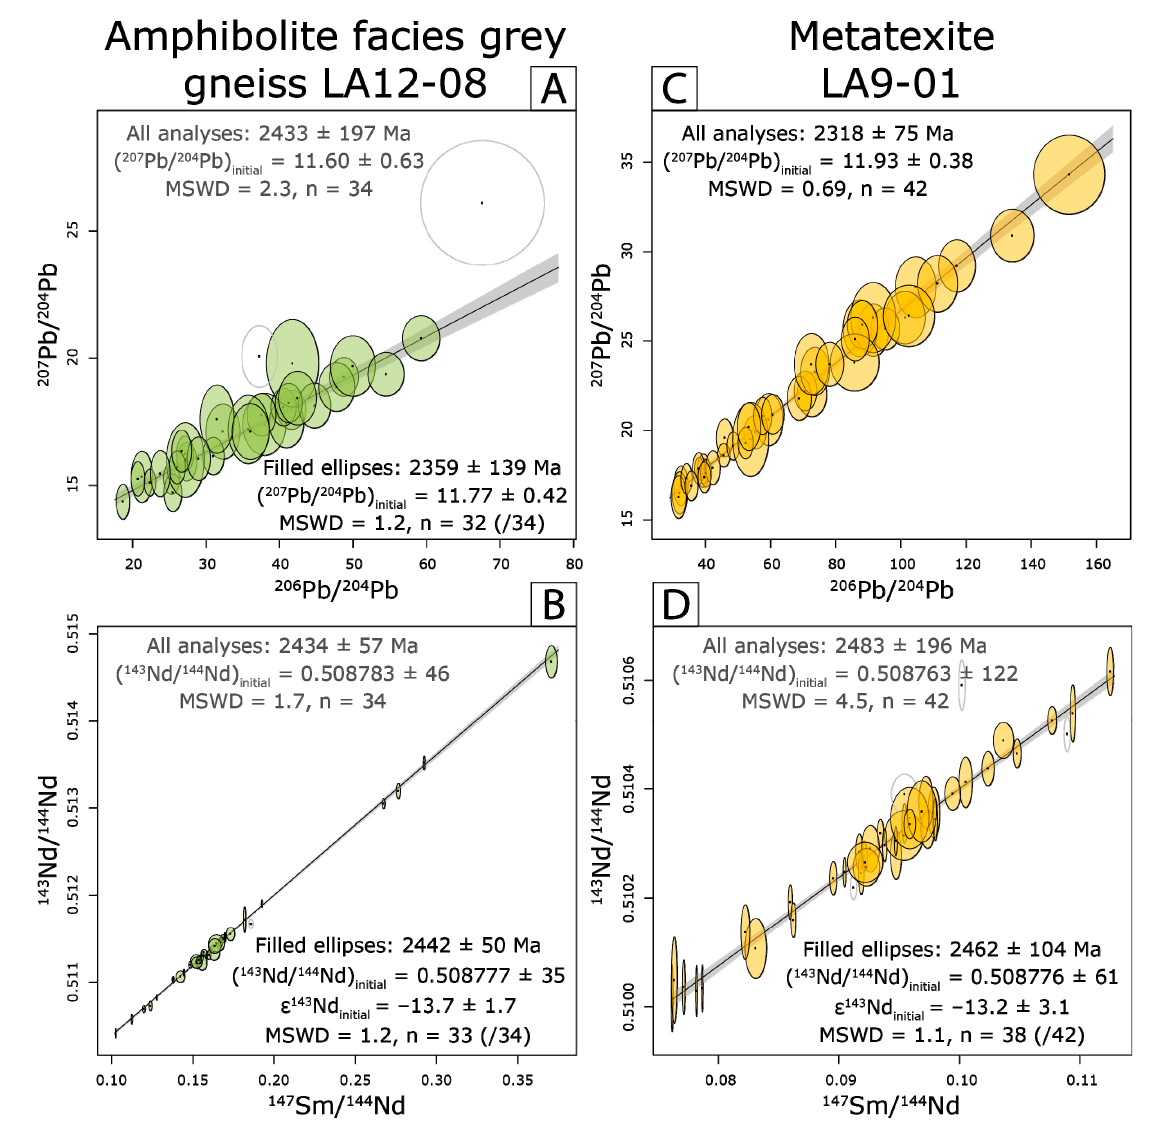
Figure 3. Results of the apatite U–Pb/Sm–Nd LASS analyses conducted in this study. ( A ) Apatite Pb–Pb isochron diagram for amphibolite facies grey gneiss LA12-08. ( B ) Apatite Sm–Nd isochron diagram for the amphibolite facies grey gneiss LA12-08. ( C ) Apatite Pb–Pb isochron diagram for the metatexite LA9-01. ( D ) Apatite Sm–Nd isochron diagram for the metatexite LA9-01. Uncertainty ellipses are shown at 95% confidence level. Uncertainty in apparent ages and in initial (Pb and Nd) ratios are reported at 95% confidence level. External uncertainties have been propagated in final ages and ratios. All diagrams plotted with IsoplotR-version 1001/639 [55]. Initial epsilon ( ε ) deviations are calculated with Sm–Nd isochron apparent age following Model-1 algorithm of [57] and include uncertainty in apparent age, CHUR model and decay